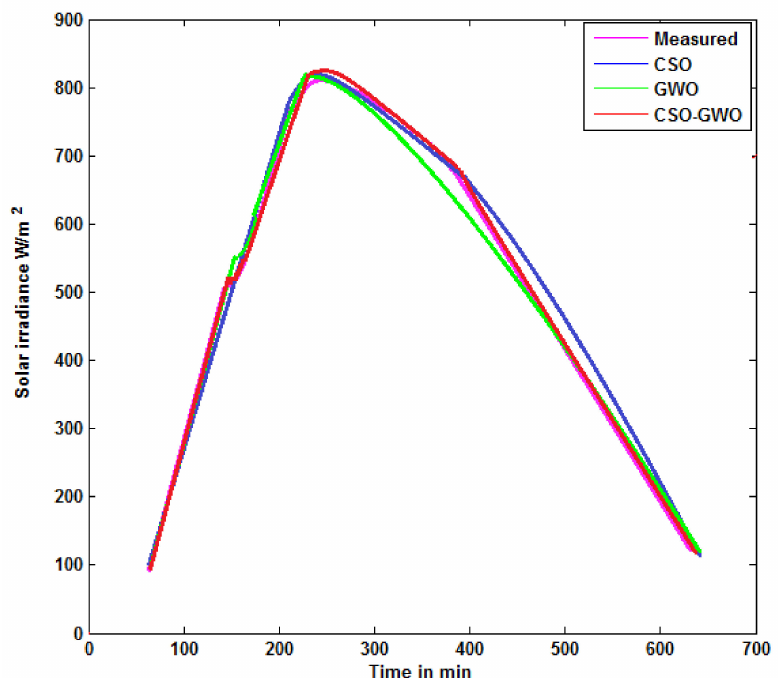
Figure 7. Hourly prediction of solar irradiance using CSO, GWO, and hybrid CSO-GWO with LSTM